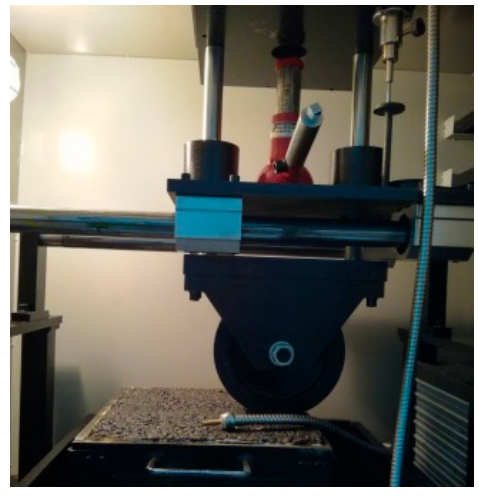
Figure 7. Rutting test process.